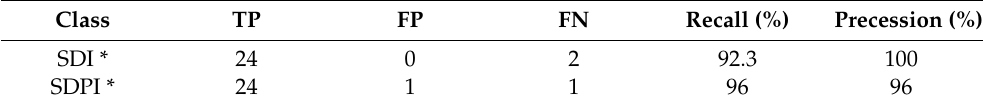
Table 5. The performance criteria of detecting SDI and